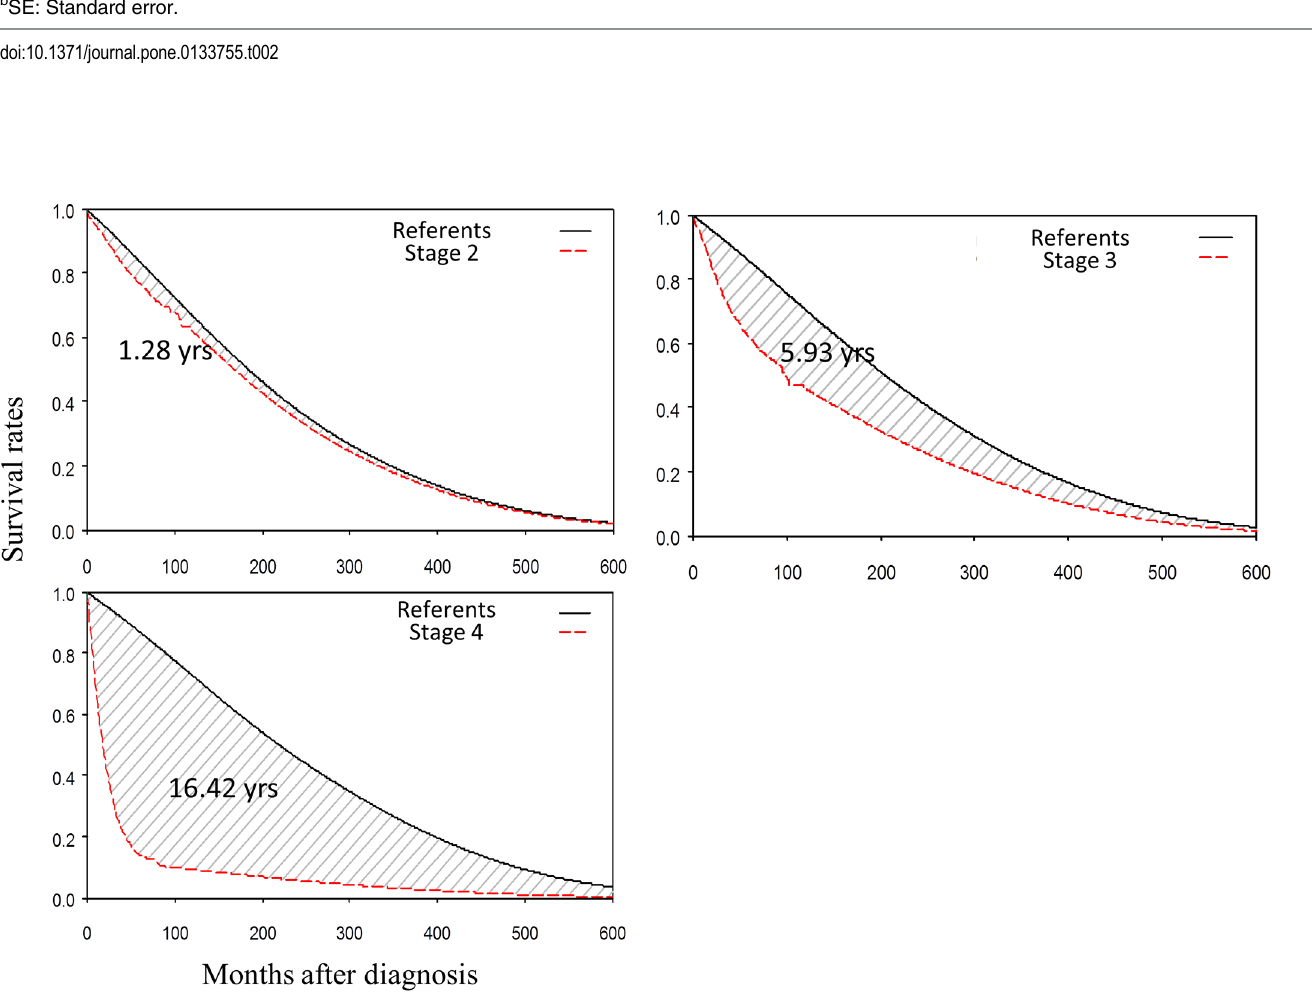
Fig 3. Average expected years of life lost (EYLL) of colon cancer patients by different stages. The differences of LE between colon cancer patients and the sex- and age-matched referents were represented in the shadowed